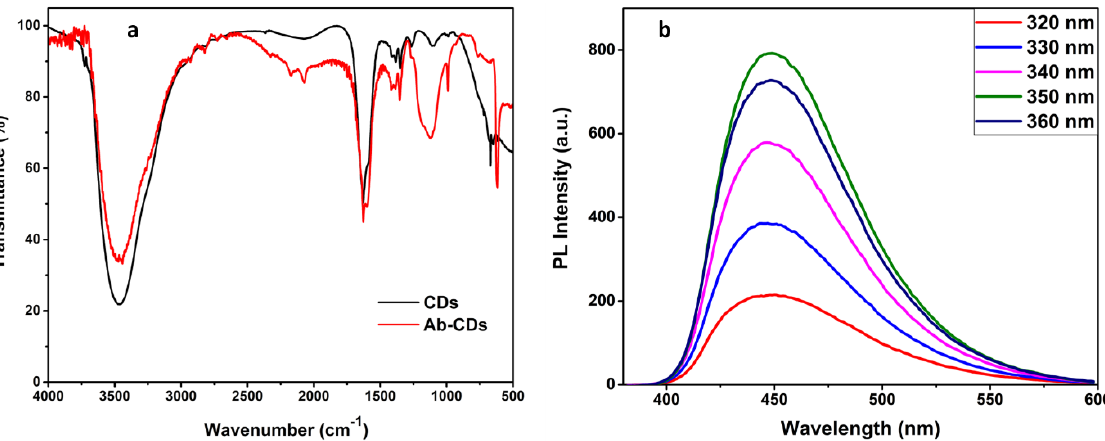
Figure 2. FTIR spectra of CDs and Ab − conjugated CDs ( a ) and PL graph of CDs at different excitation wavelengths ( b ).